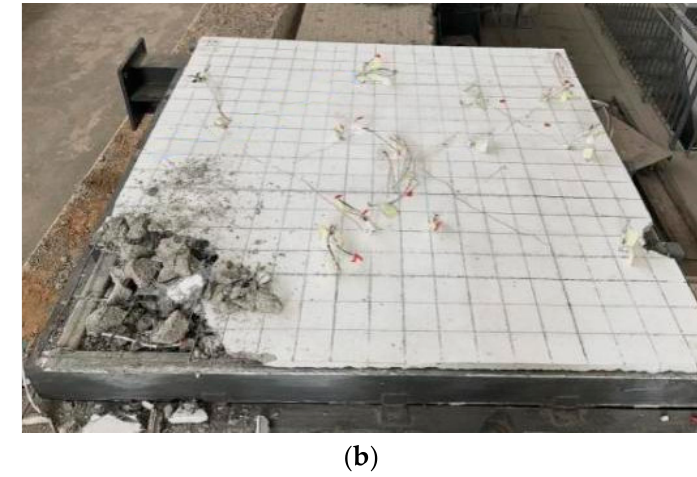
Figure 8. Damage to the WP-1 specimen: ( a ) the stripping of the fine aggregate concrete layer and C-shaped steel; ( b ) the failure mode after loading.